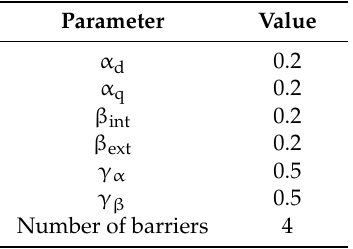
Table 1. Pre-defined rotor geometric parameters.